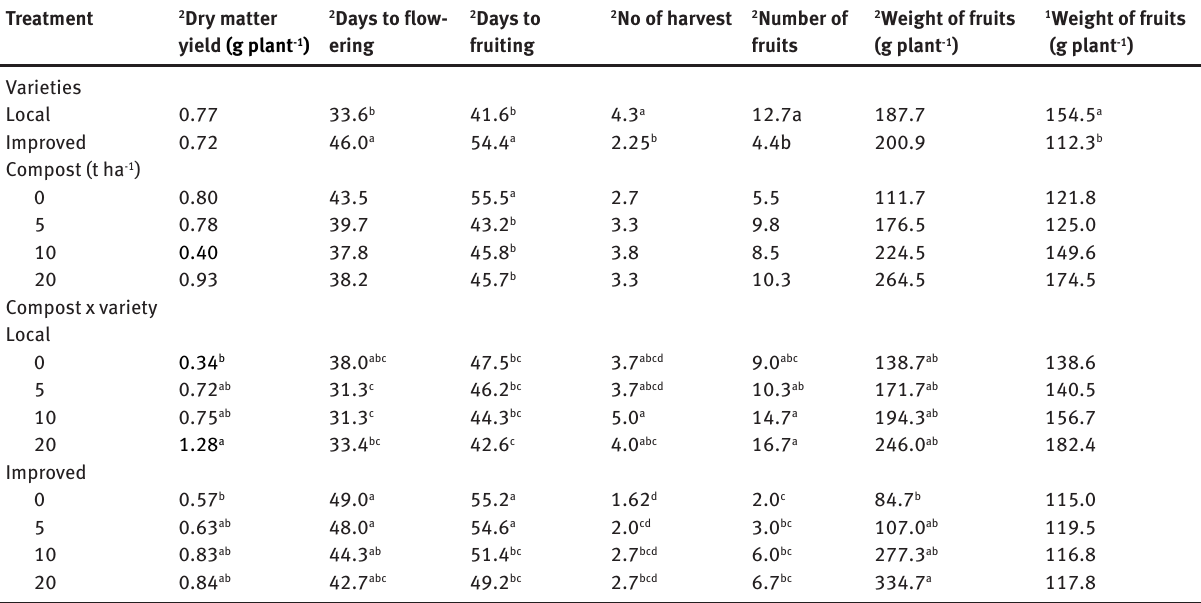
Table 6: Yield characteristics of tomato in pot experiments